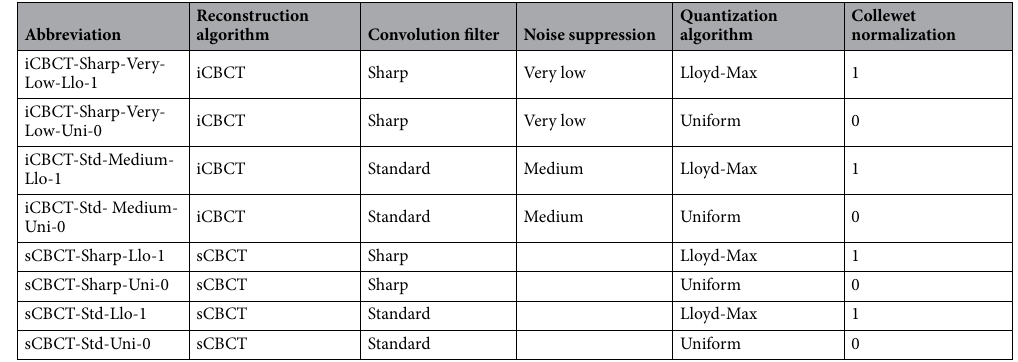
Table 1. Reconstruction and pre-processing parameters considered in this work. ‘1’ means Collewet Normalization was applied and ‘0’ means Collewet Normalization was not